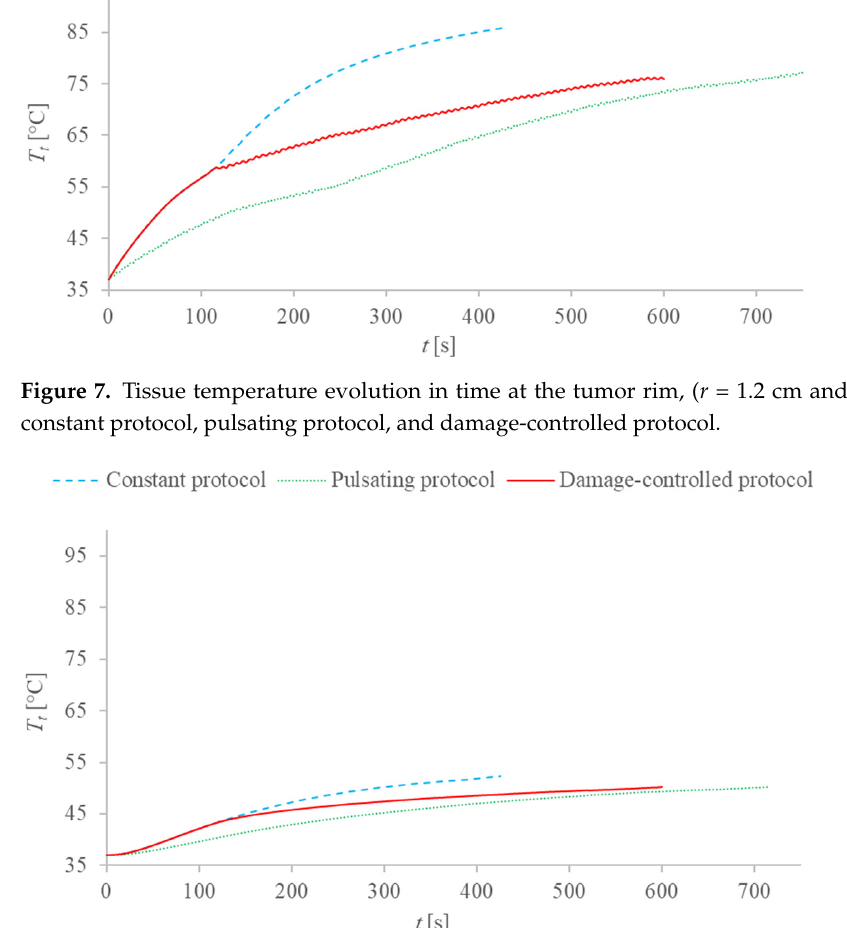
Figure 7. Tissue temperature evolution in time at the tumor rim, ( r = 1.2 cm and z = 0.0 cm) for constant protocol, pulsating protocol, and damage-controlled protocol.